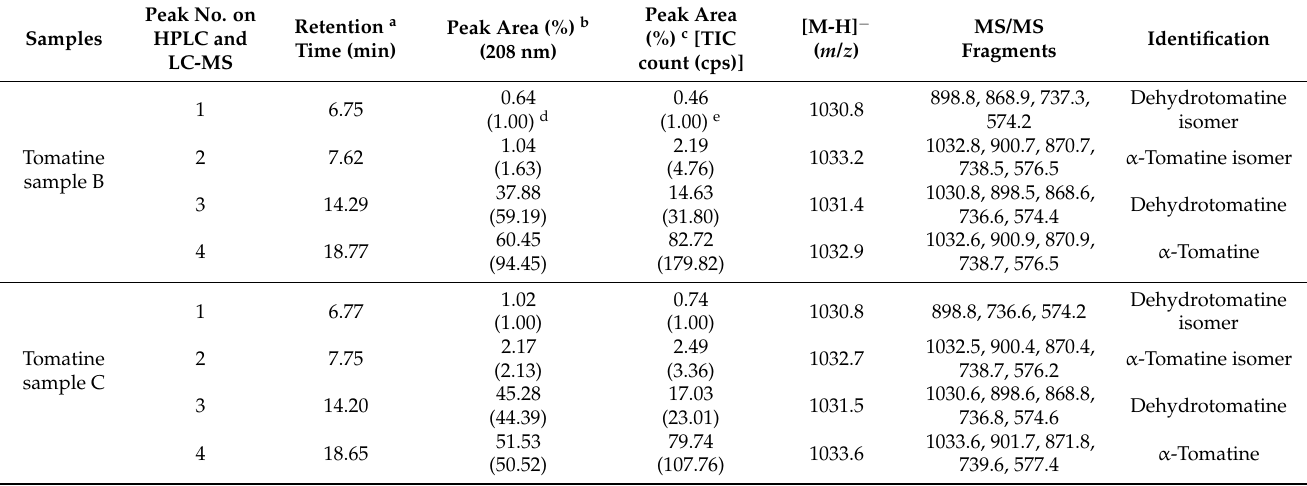
Table 3. Retention times, peak areas, MS, and MS/MS by LC-MS of tomatine samples B and C (column packing, 5 µ m particle size) a